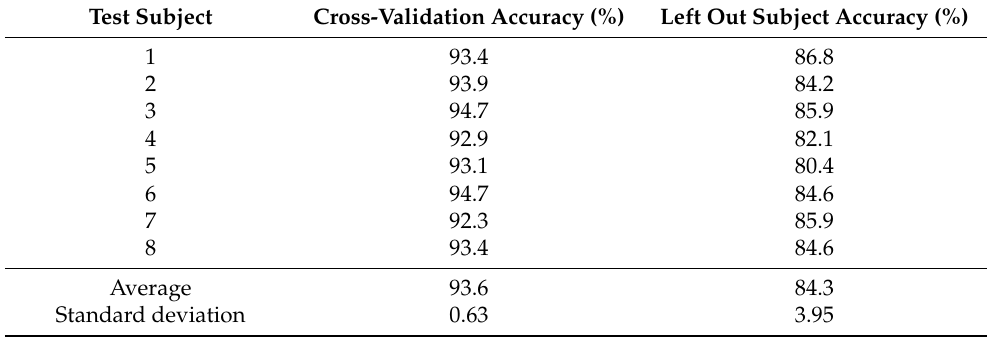
Table 4. Result of leave-one-out validation.